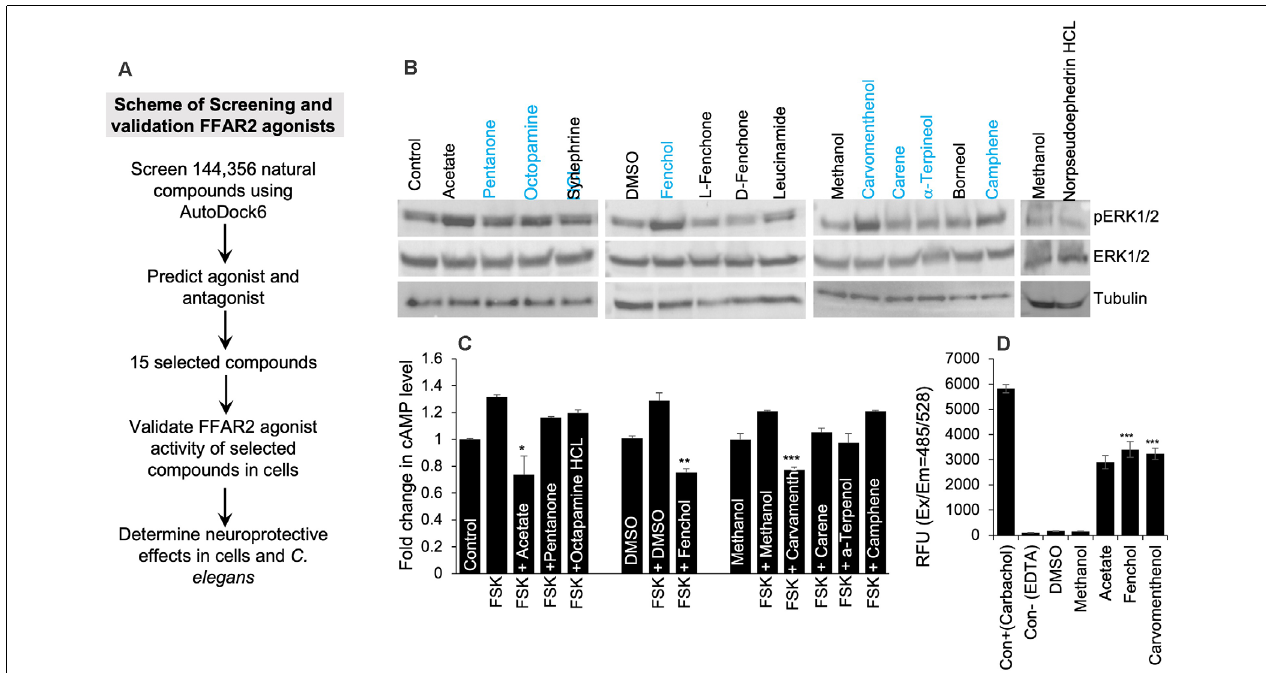
FIGURE 2 | In silico and in vitro screening of FFAR2 activators discovered Fenchol as the most effective activator of FFAR2 signaling. (A) Schematic of screening FFAR2 activators and their validation for ameliorating AD-like phenotype. (B) FFAR2 activating potential of selected compounds in terms of increasing phospho-ERK1/2 levels. (C) Further selected compounds ( n = 7) were showing a reduction in Forskolin (FSK) induced cAMP in SK-N-SH cells. (D) In addition, further selected ( n = 2) for increasing intracellular calcium- another indication of FFAR2 signaling activation. Data are shown as the mean ± S.D. ( n = 3 experiments